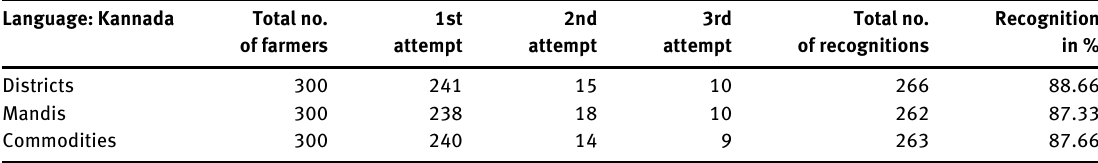
Table 20: Performance Evaluation of On-Line Speech Recognition Accuracy Testing by Farmers in Field